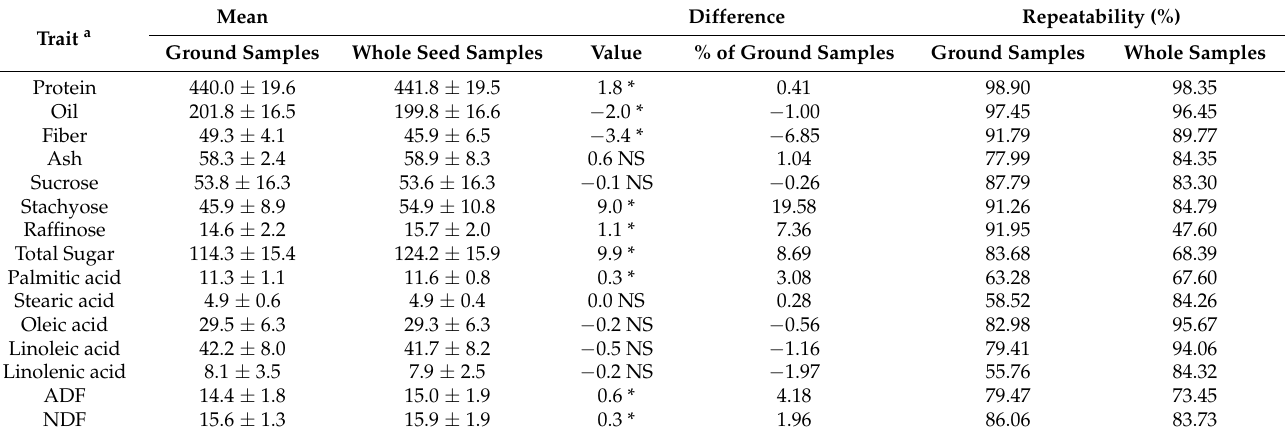
Table 3. Means ( ± sd), differences and repeatability of seed composition traits for whole and ground edamame seed all over three drying methods and three years (2018–2020).